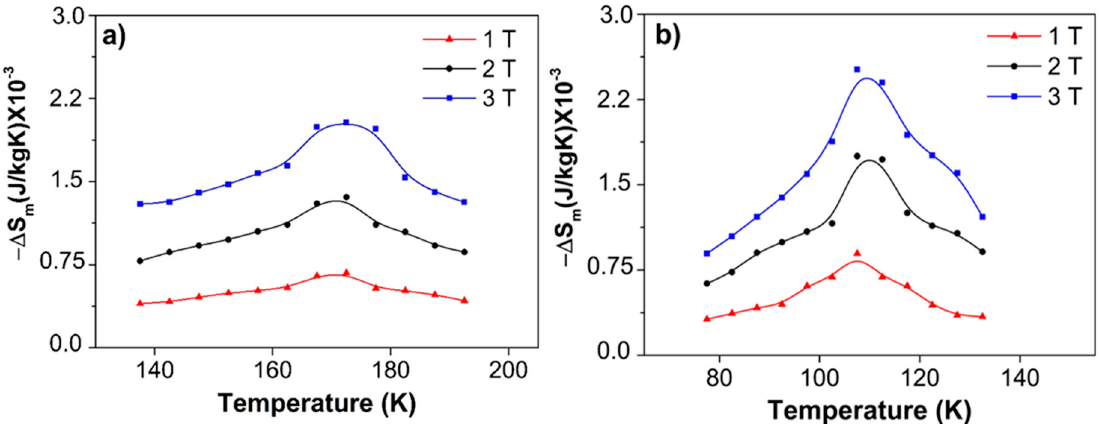
Figure 6. −∆ S m as a function of the temperature and magnetic field in samples subjected to ( a ) quenching and ( b ) normalizing.